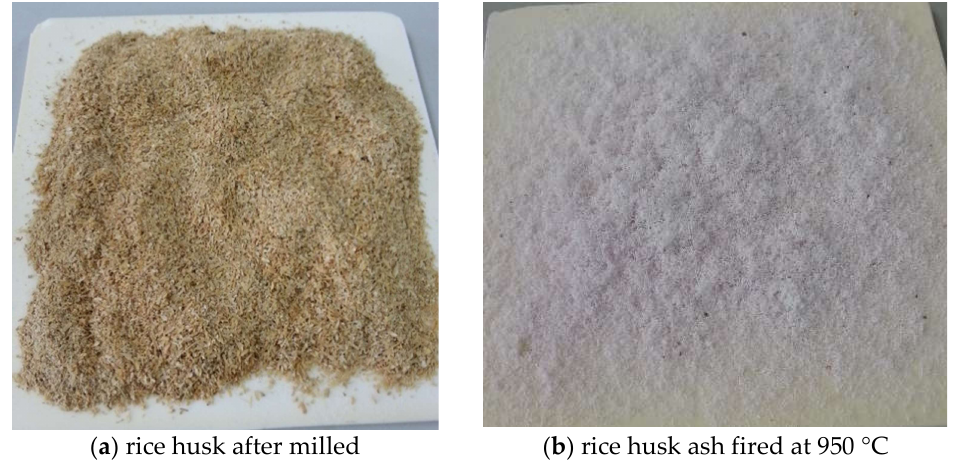
Figure 5. ( a ) Rice husk after milled and ( b ) rice husk ash after firing at 950 ◦ C.